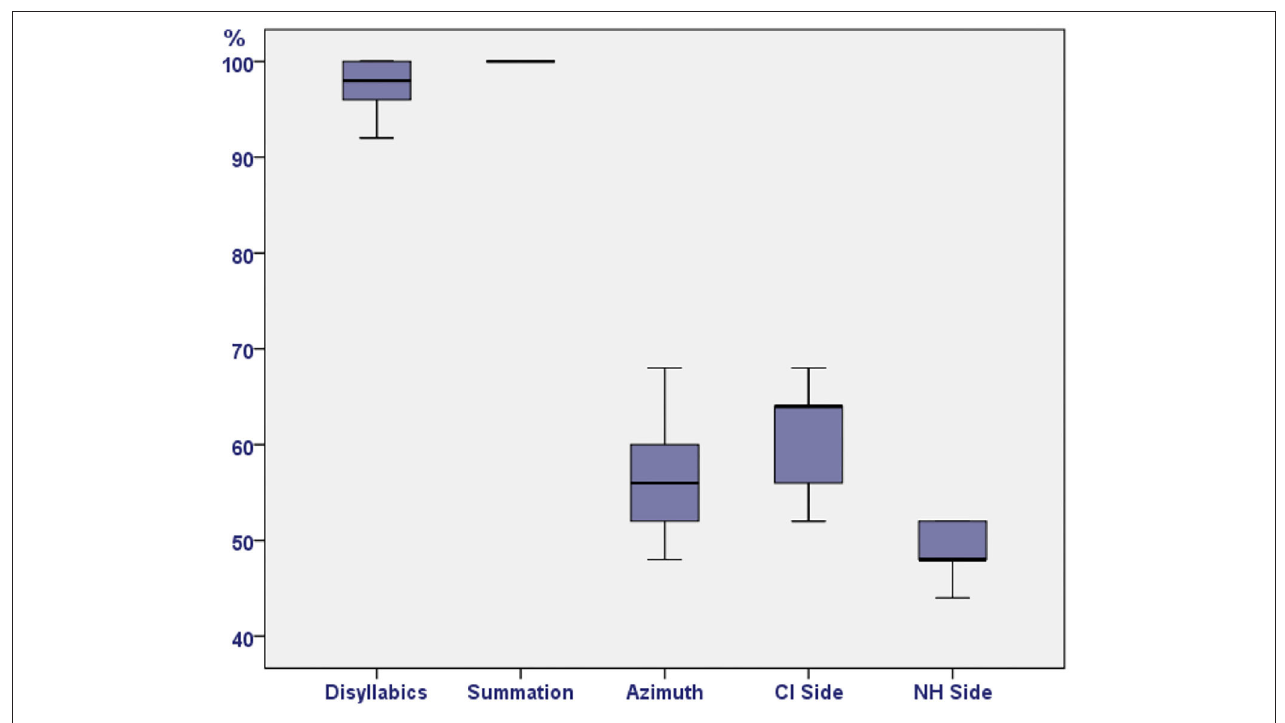
FIGURE 1 | Acquired single-sided deafness: speech test results.